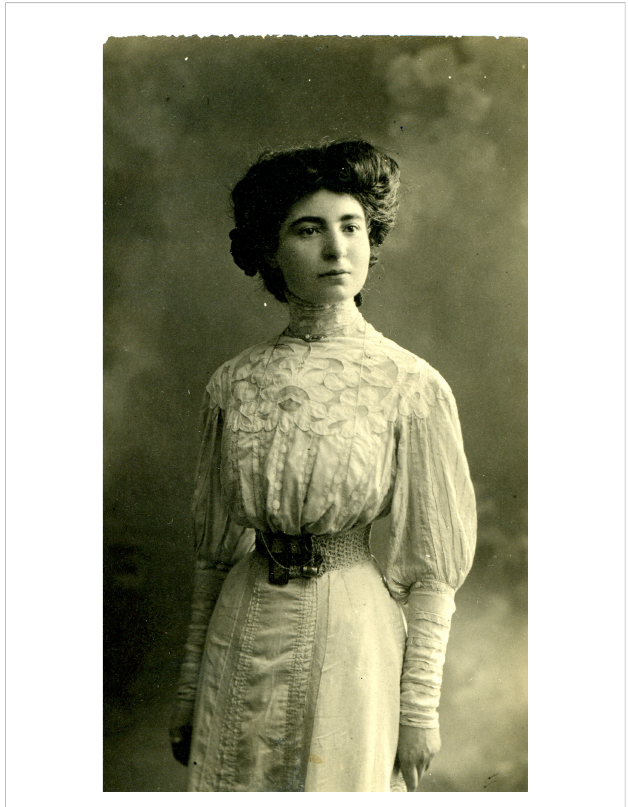
FIGURE 1 Portrait of Eva Mameli Calvino (courtesy of the Biblioteca Civica of Sanremo,